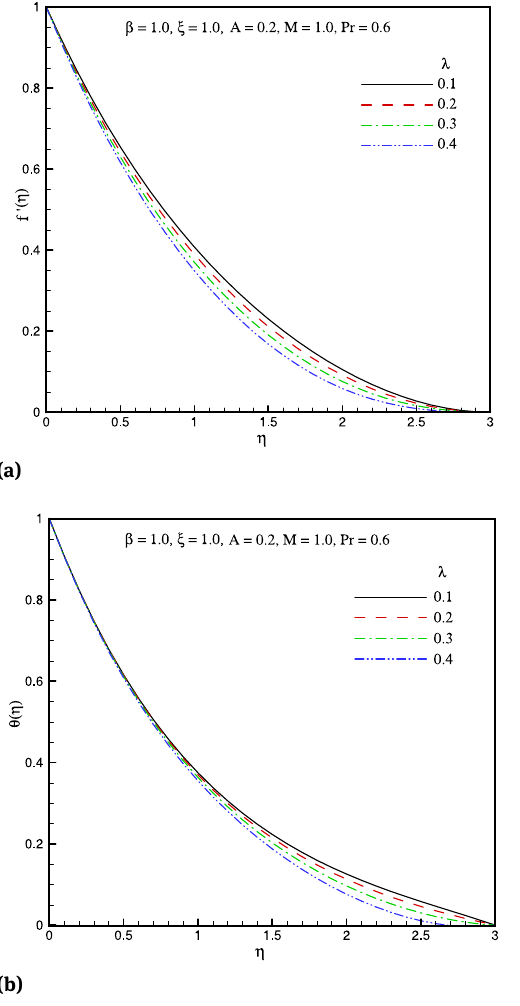
Figure 4: Simulated velocity and temperature profiles for different values of unsteadiness parameter